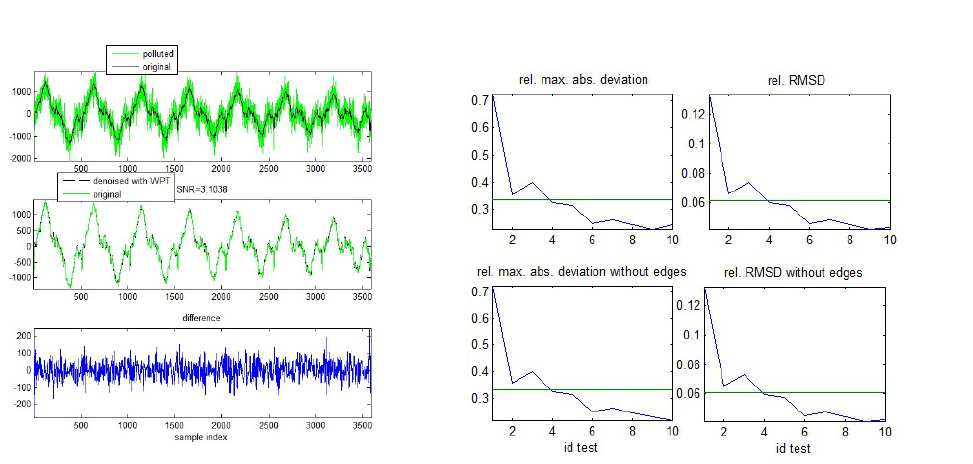
Figure 15. Descending slope, M = 0.06, most significant noise. Top - Analysed signals (orig- inal and polluted). Middle – original signal and signal denoised with WPT. Bottom – di ff erence between original signal and signal denoised with WPT.